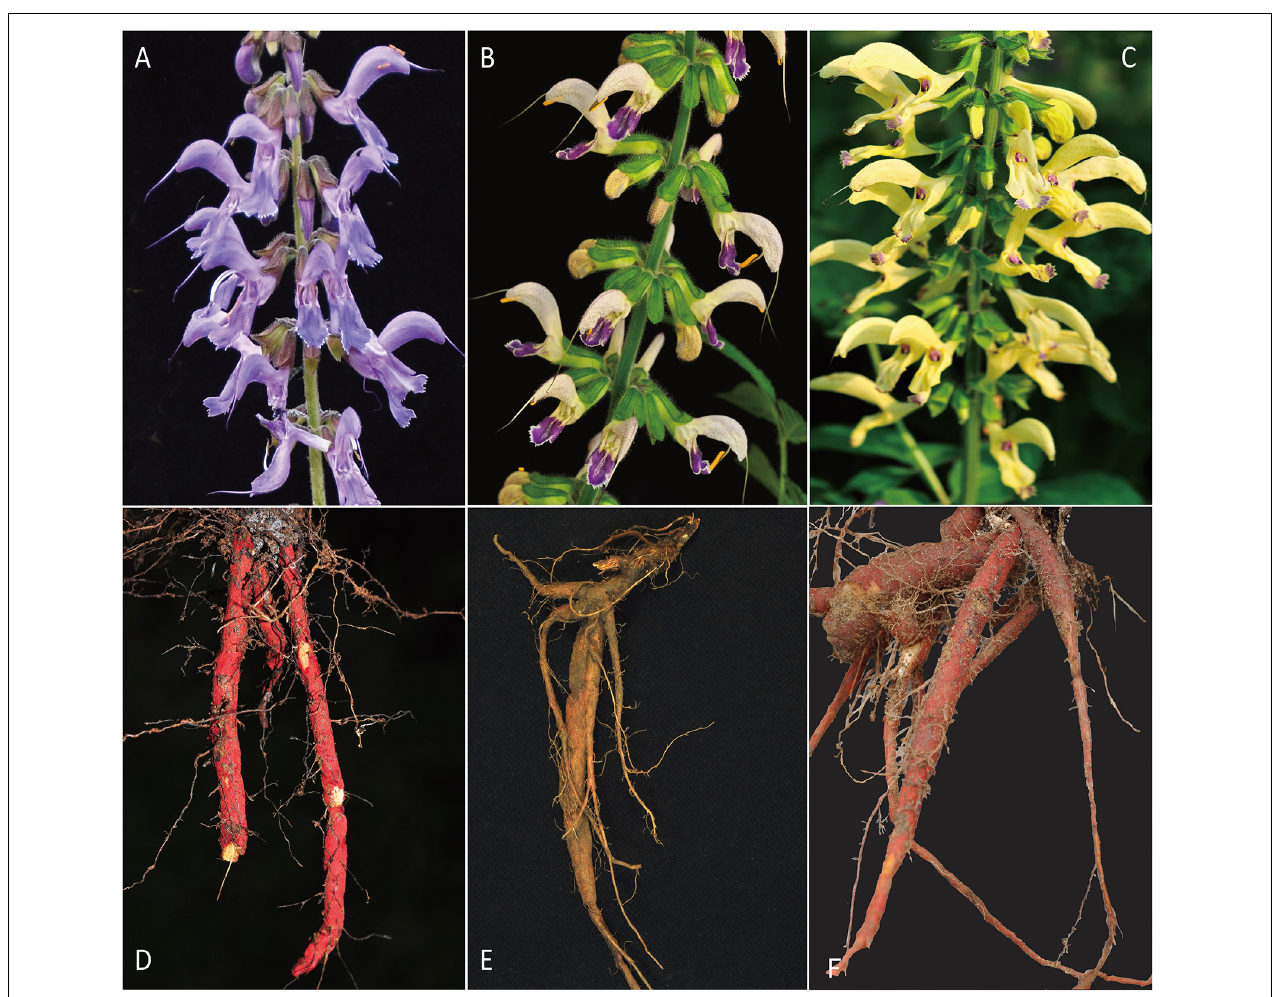
FIGURE 1 | Flower and root morphology the three studied species. (A) flower of S. miltiorrhiza . (B) flower of S. bowleyana . (C) flower of S. paramiltiorrhiza. (D) root of S. miltiorrhiza . (E) root of S. bowleyana . (F) root of S. paramiltiorrhiza